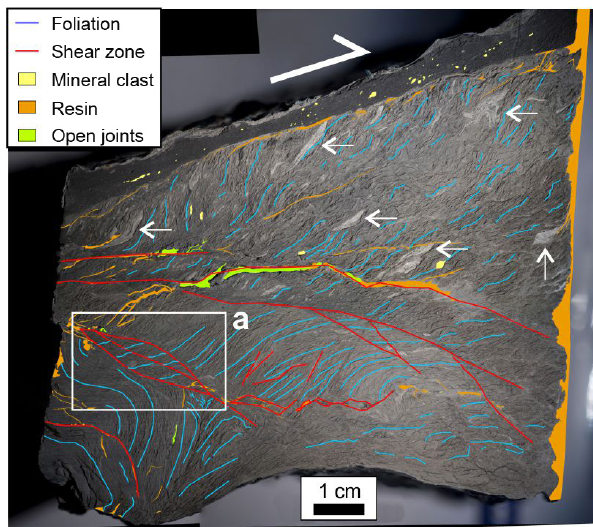
Figure 15. Shaded-light photograph and foliation sketches of water- immersed sample BPS12-4. Note the dark band of gouge on the sample top and brighter (calcite-rich) areas, indicated by arrows; a is a detail shown in Fig. 14c and